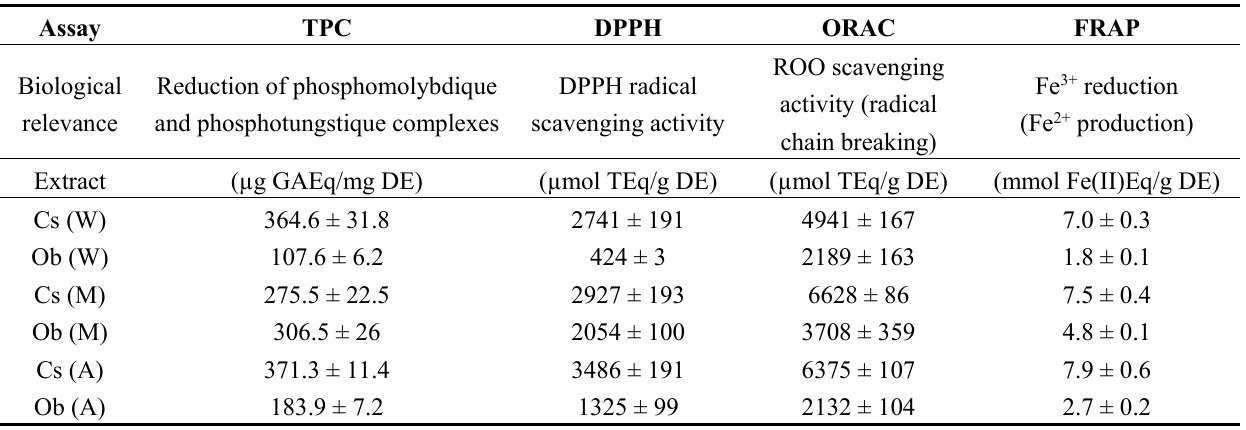
Table 1. Oenocarpus bataua and Camellia sinensis total phenolics content and in vitro antioxidant